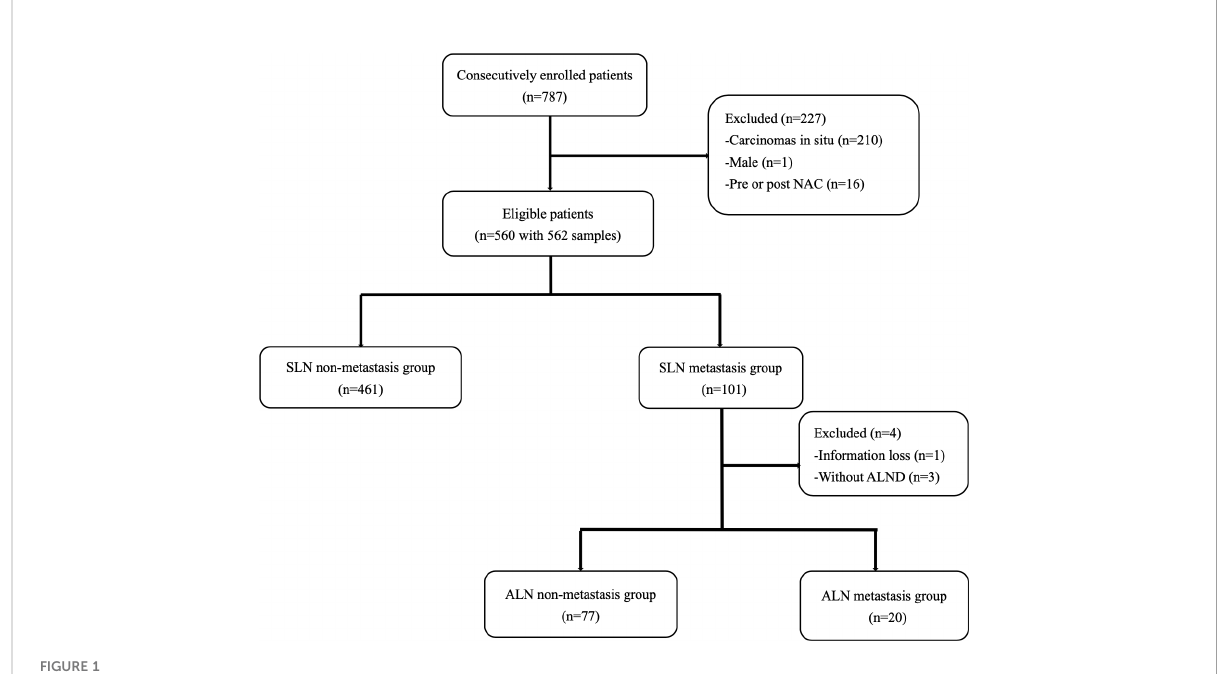
FIGURE 1 Study design and